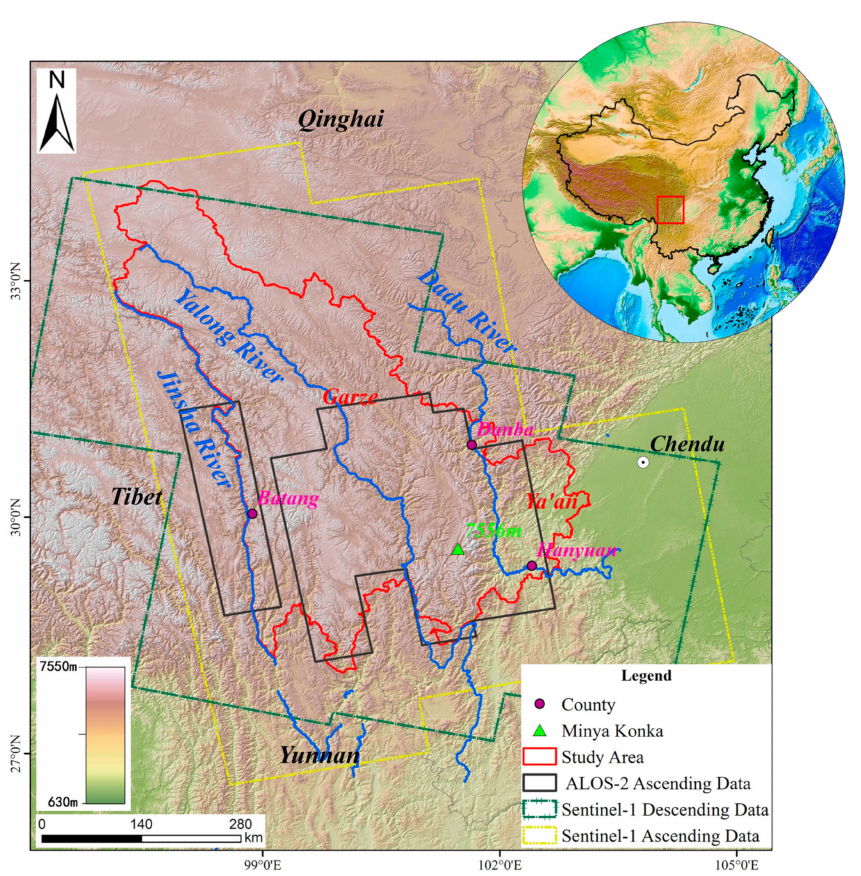
Figure 1. The location of the study area and the distribution range of SAR data.